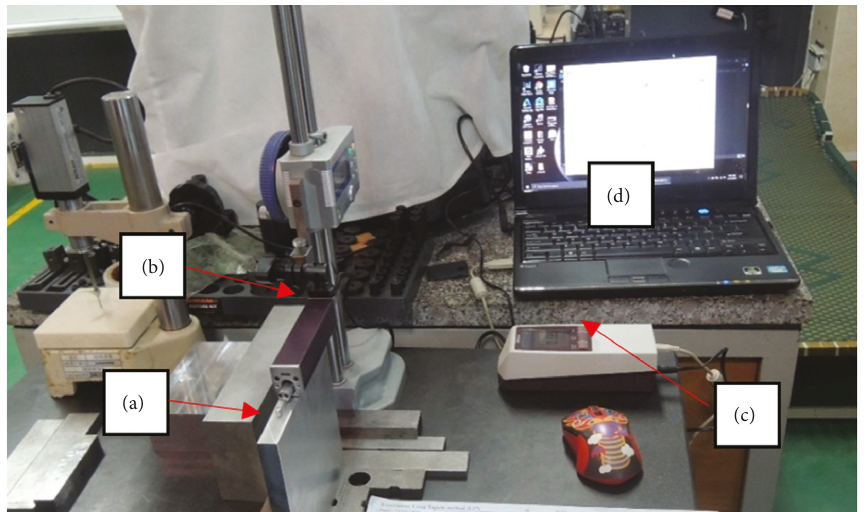
Figure 5: Surface-roughness measurement setup: a: workpiece; b: surface roughness sensor; c: data processing; d: PC and